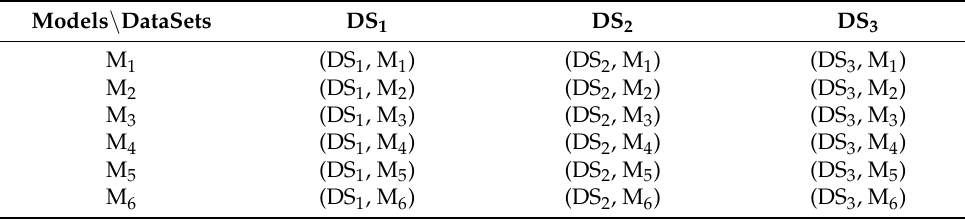
Table 3. Total combinations of experiments (#Experiments = 18).